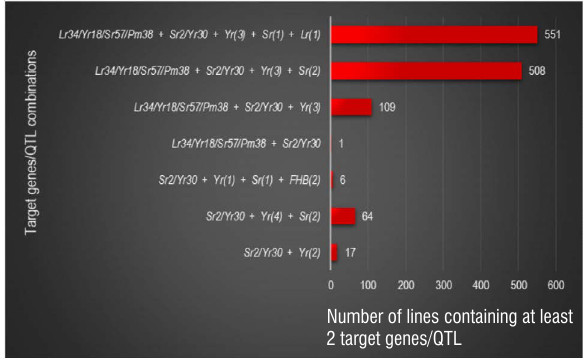
Number of lines containing at least 2 target genes/QTL Complement of rust resistances incorporated in the Sensako doubled haploid marker-assisted selection programme. Numbers in brackets indicate the maximum number of genes/quantitative trait loci (QTL) screened for in the specific combination. For each combination, lines containing at least